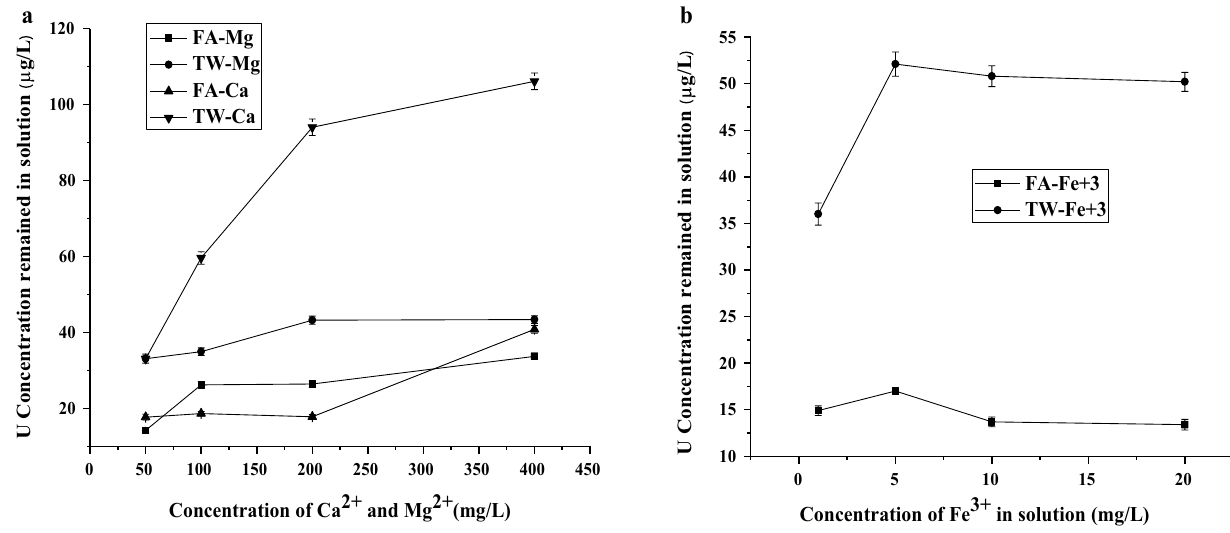
Concentration of Ca 2+ and Mg 2+